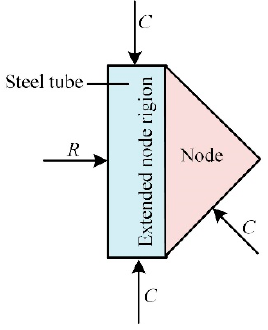
Figure 8. The load of the extended node region.